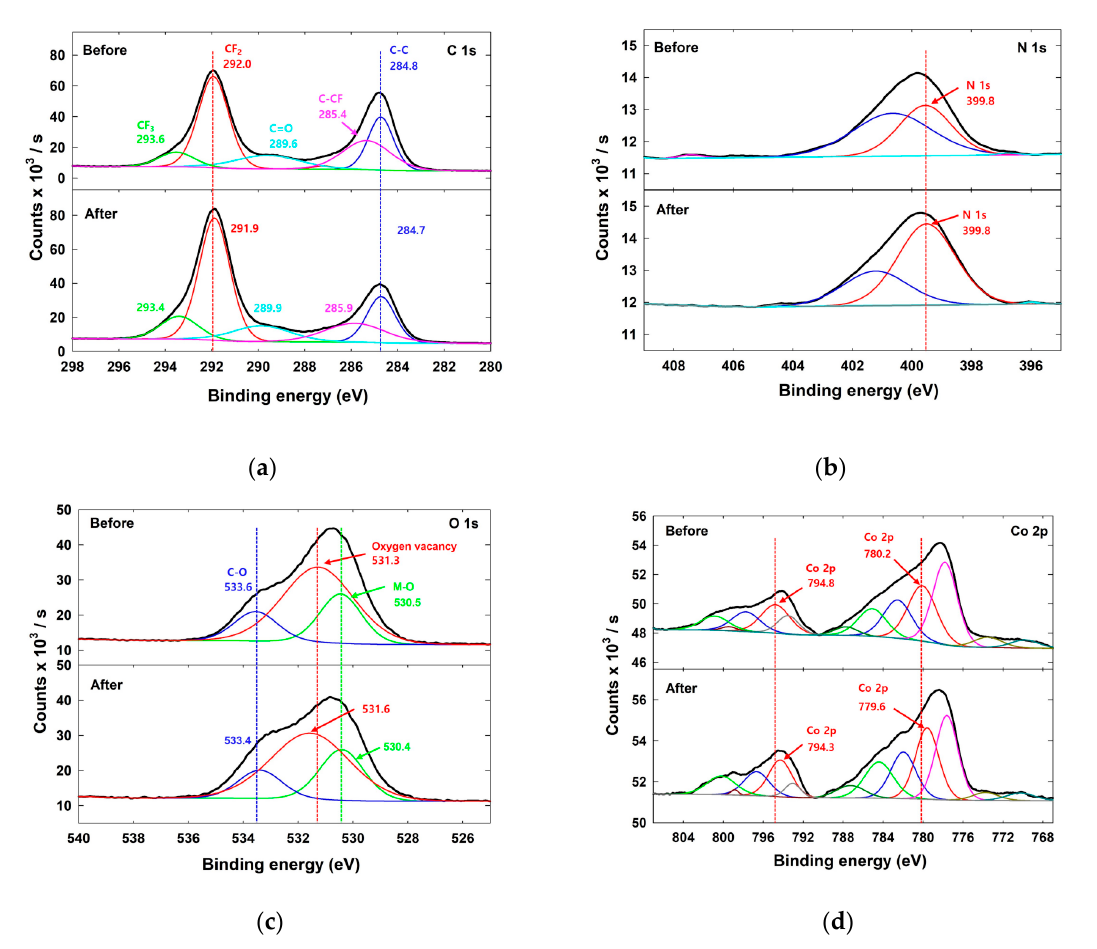
Figure 5. XPS spectra for ( a ) C 1s, ( b ) N 1s, ( c ) O 1s, and ( d ) Co 2p regions using a catalyst 1 -modified ITO electrode before and after electrochemical measurements. The colored lines show the result of deconvolution.